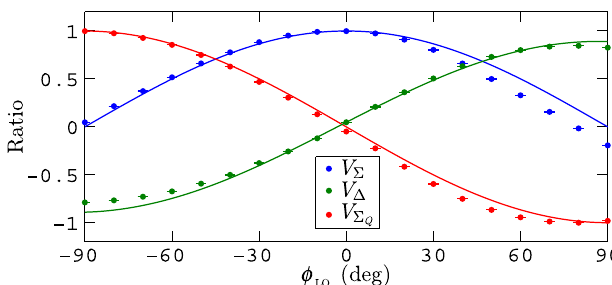
FIG. 11. Illustrative measured V Δ , V Σ and V Σ signals, vs LO Q signal phase ϕ (degrees of 714 MHz); each signal has been LO Þ 1 = 2 , which removes the normalized pulse-by-pulse by ð V 2 Σ þ V 2 Σ Q effects of pulse-by-pulse fluctuations in the beam charge. 50 pulses are averaged at each phase setting. Each line shows the respective function in Eqs. (16) – (18); the V Δ line was normalized ¼ 0 to the data point at ϕ LO